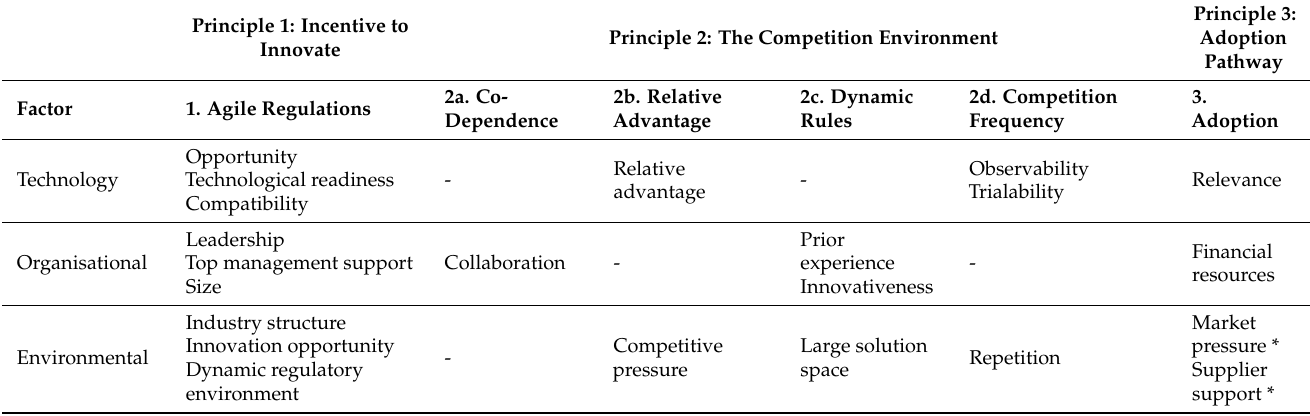
Table 1. TOE factors used in developing the SCI